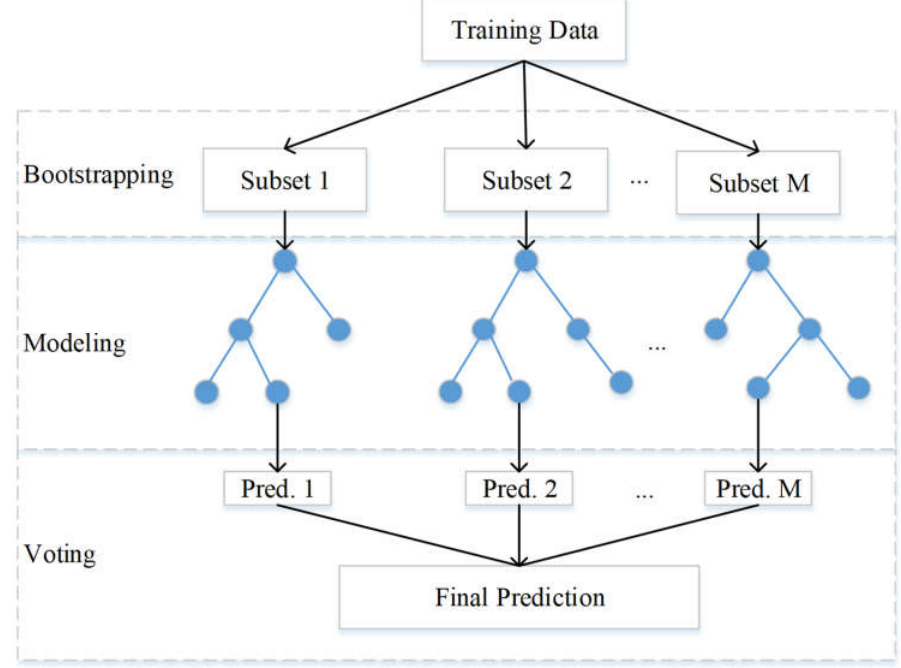
Figure 4. Random forest flowchart.